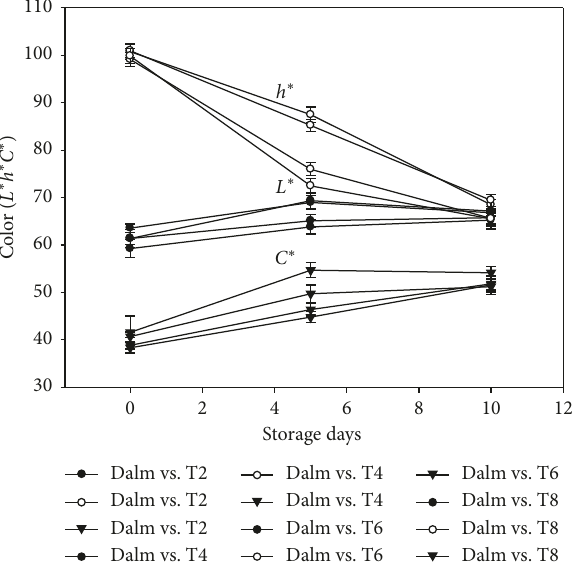
Figure 4: Stenospermocarpic mango “Ataulfo” fruit coated with 2% starch. T2 (banana “Pear”), T4 (soursop), T6 (mango “Ataulfo” niño), and T8 (control fruit: uncoated). Fruit stored at